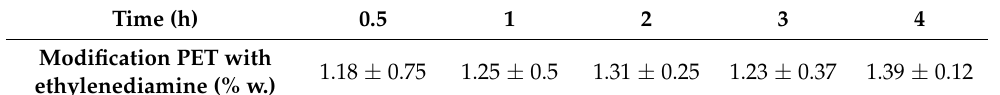
Figure 1. ( a ) Weight loss of PET films in the aminolysis reaction at different times, ( b ) IR-ATR spectra of PET films after aminolysis reaction at different times. Table 1. Modification percentage of the PET film by the aminolysis reaction at different times, quantified by acid-base titration.